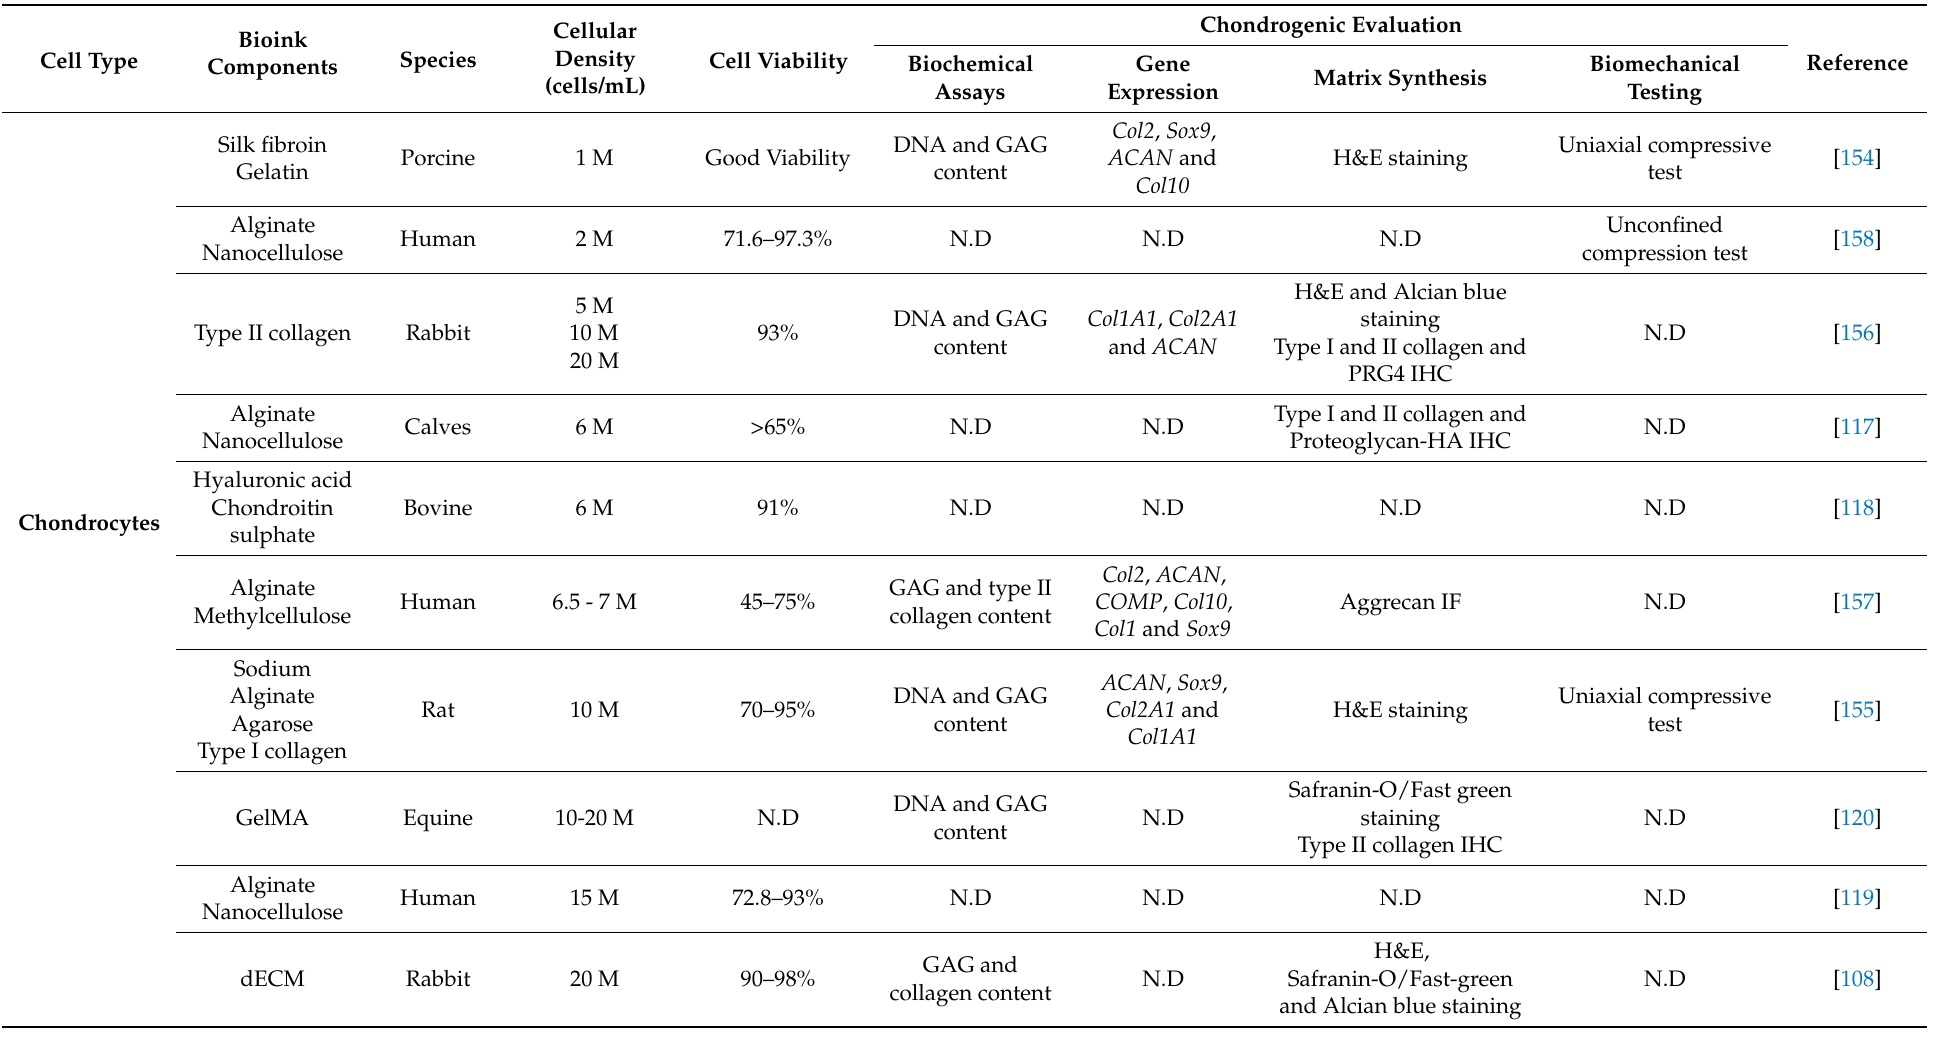
Table 2. Comparison of cell viability and chondrogenic evaluation depending on cell types, origins, and densities used to date in extrusion-based processes for cartilage tissue engineering.